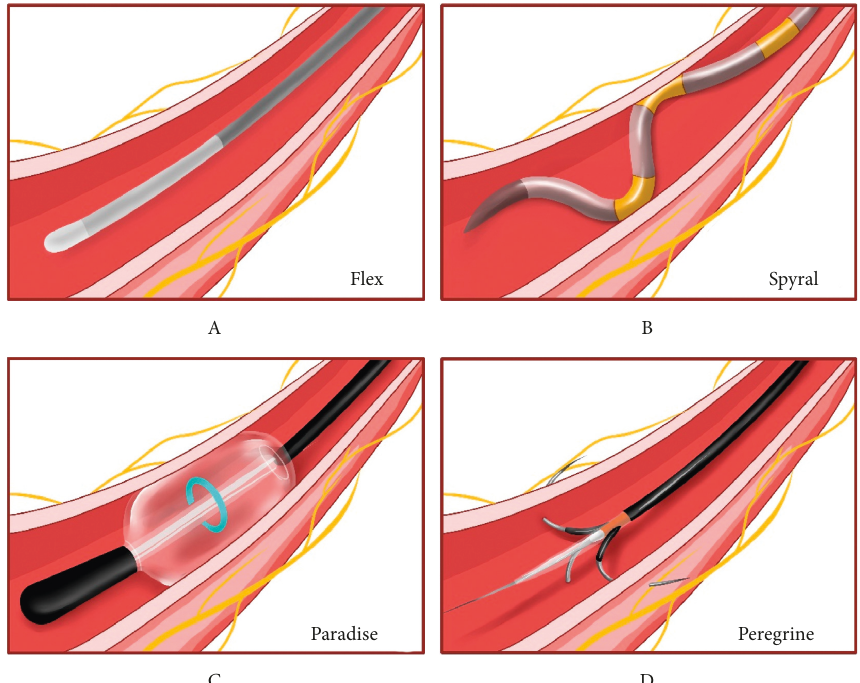
Figure 4: Different catheter-based renal denervation devices for reduction of sympathetic nerve activity and blood pressure.